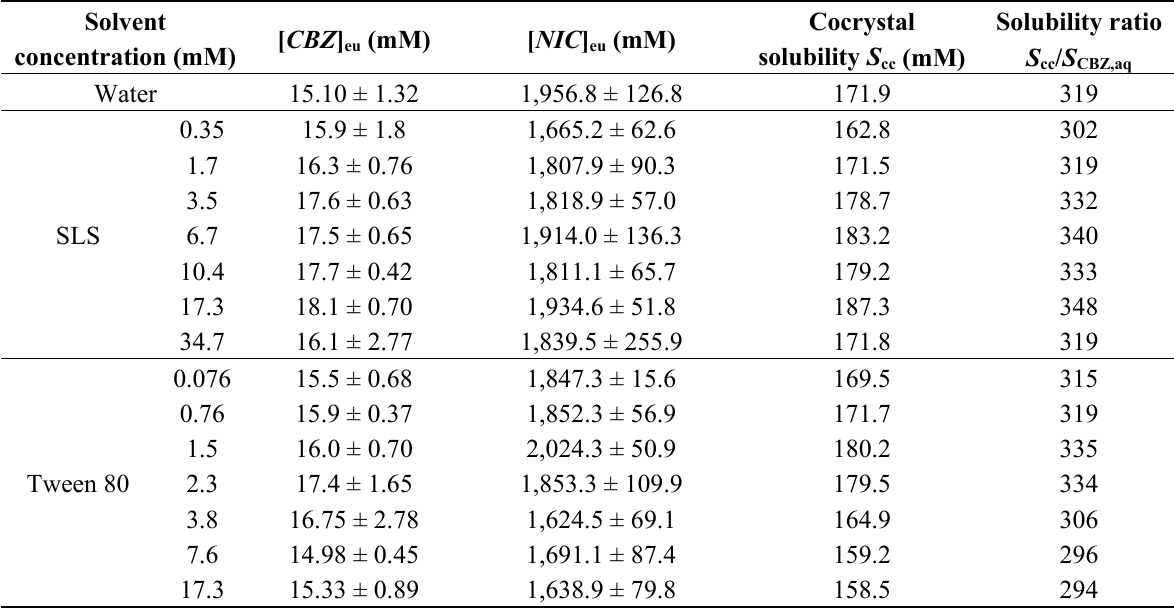
Table 2. CBZ–NIC cocrystal eutectic point, cocrystal solubility and solubility